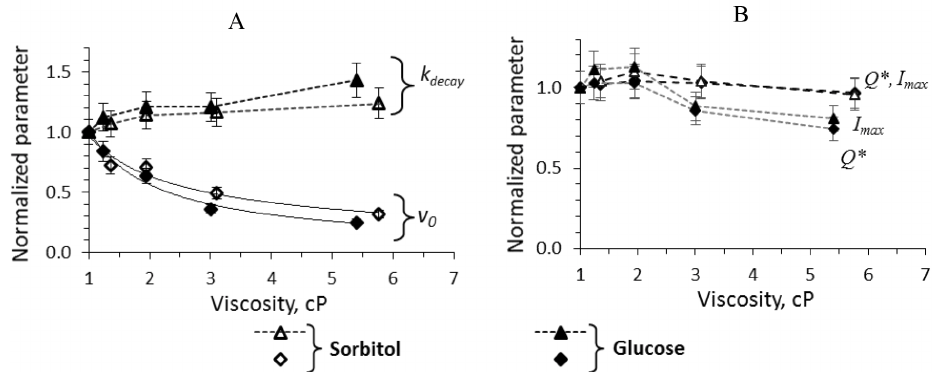
Figure 10. Dependence of the kinetic characteristics of luciferase reaction in the presence of glucose (solid markers) and sorbitol (empty markers) on solution viscosity: decay constant and initial veloc- ity ( A ); peak intensity and total quantum yield ( B ). The solid lines are the power law approximations with the exponent of − 0.85 for glucose solutions and − 0.62 for sorbitol solutions. The dashed lines are shown to guide the eyes. A decanal concentration in the reaction was 50 µ M. The viscosity values of the solutions were taken from [43,44] for glucose and sorbitol,